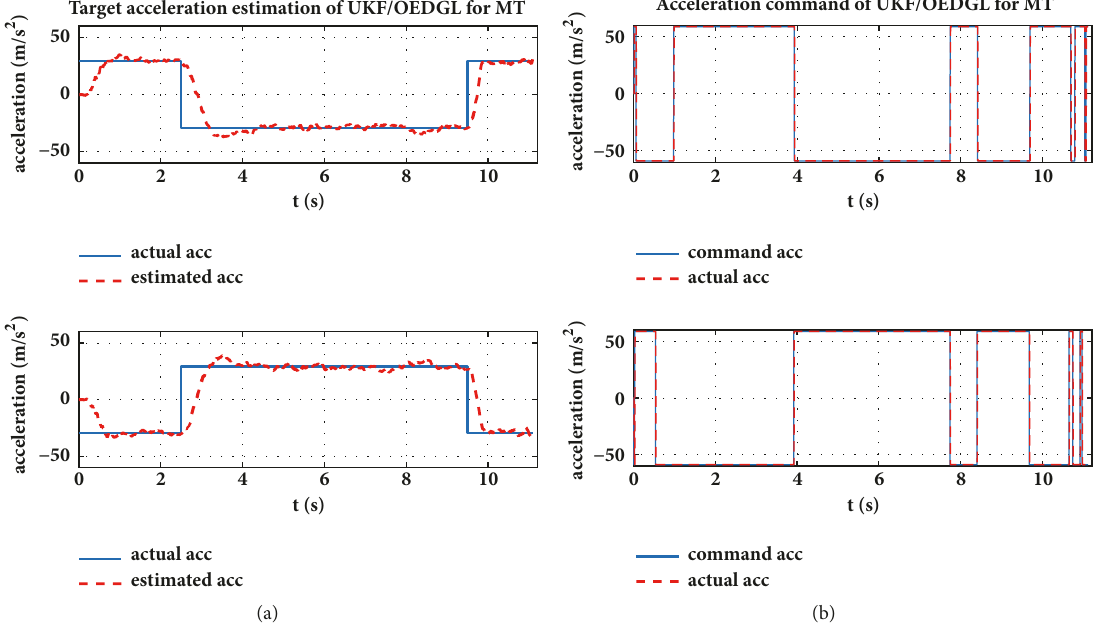
Figure 14: Target acceleration estimation and acceleration command of UKF/OEDGL for MT.